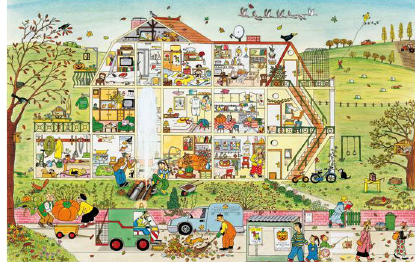
Figure 4. Rotraut Berner S., Le Livre des 4 saisons ; La Joie de Lire, Francia 2013, [4].